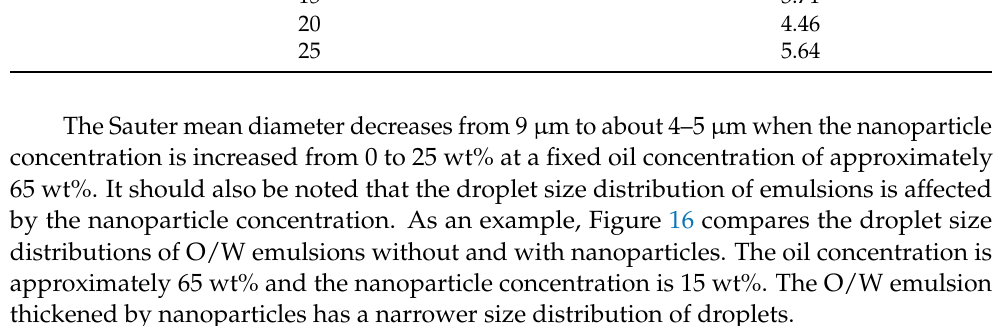
Table 4. Sauter mean diameters of O/W emulsions thickened with starch nanoparticles. The oil con- centration is fixed at approximately 65 wt%.